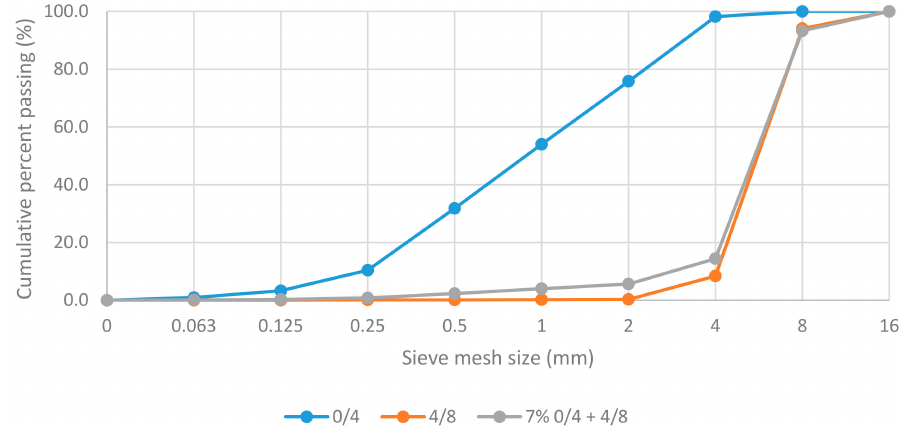
Figure 1. Sieve analysis of aggregate used in experiment.